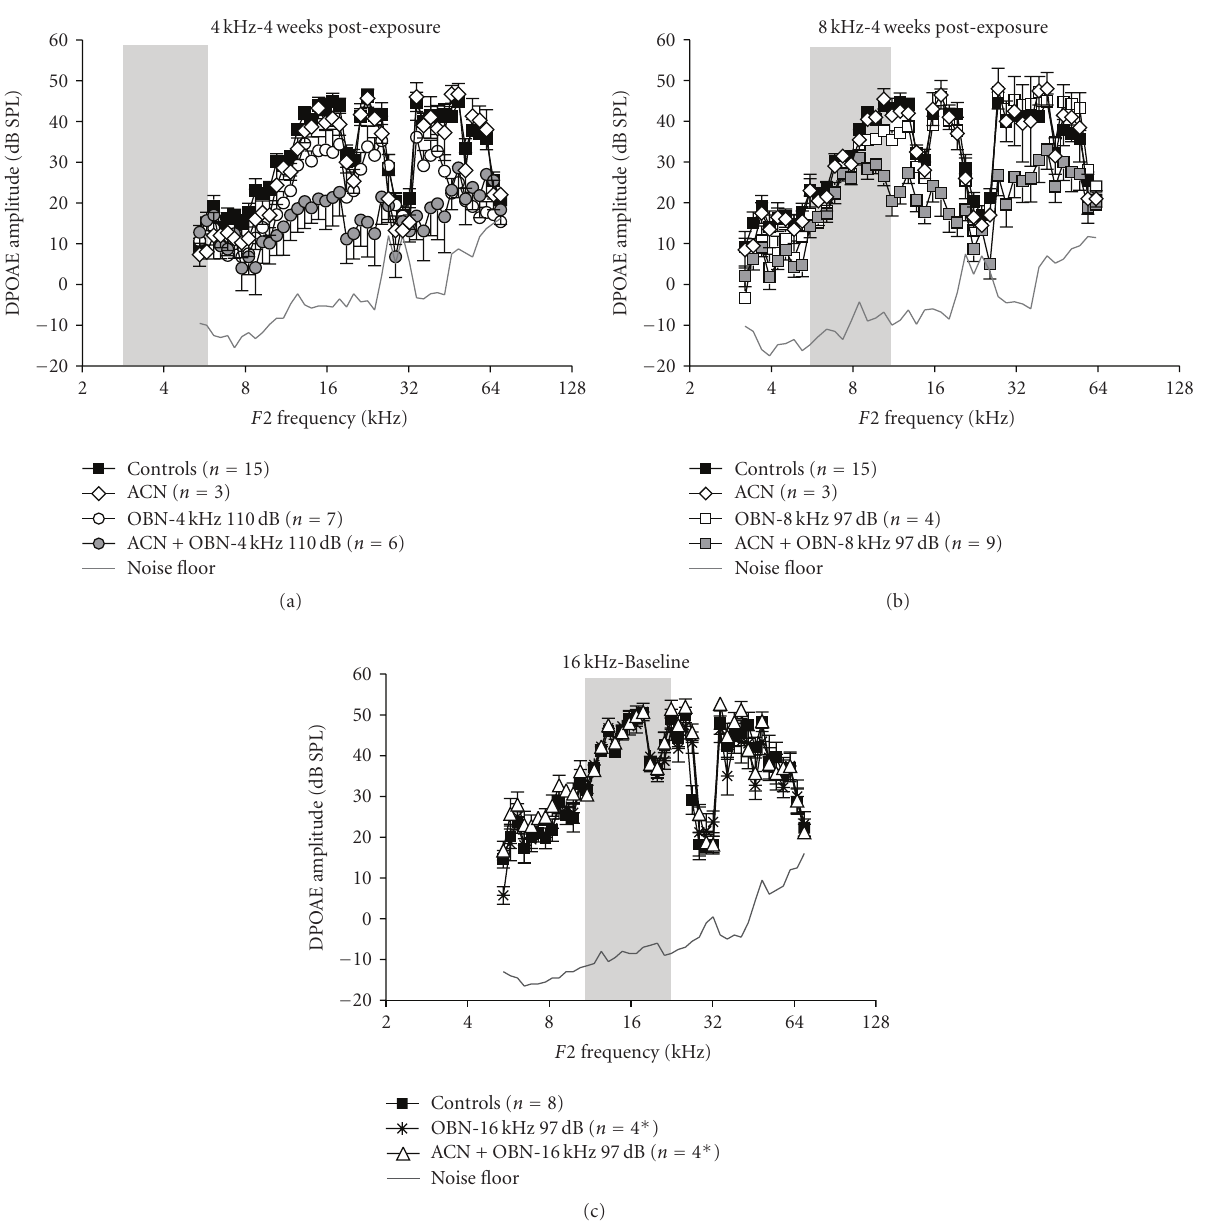
Figure 2: Four-week postexposure DPOAE amplitudes obtained from rats exposed to (a) the 110dB OBN-4 kHz with or without ACN, (b) to the 97dB OBN-8kHz with or without ACN, or (c) to the 97dB OBN-16kHz with or without ACN (see Table 1 for details). DPOAE amplitude measured in control and ACN alone animals were included in each of the graphs for reference. DPgrams were obtained with the levels of the primaries F 1 and F 2 set at 75, and with F 2 /F 1 = 1 . 25 . The tested F 2 frequencies ranged from 3.2 to 63 kHz (geometric mean frequencies: 2.9 to 56.3kHz), in 0.1 octave increments. The gray areas represent the theoretical octave-band noise frequency ranges. Error bars: ± SEM. ∗ for technical reasons only 4 subjects could be measured with DPOAEs in the OBN-16kHz and in the ACN + OBN-16 kHz